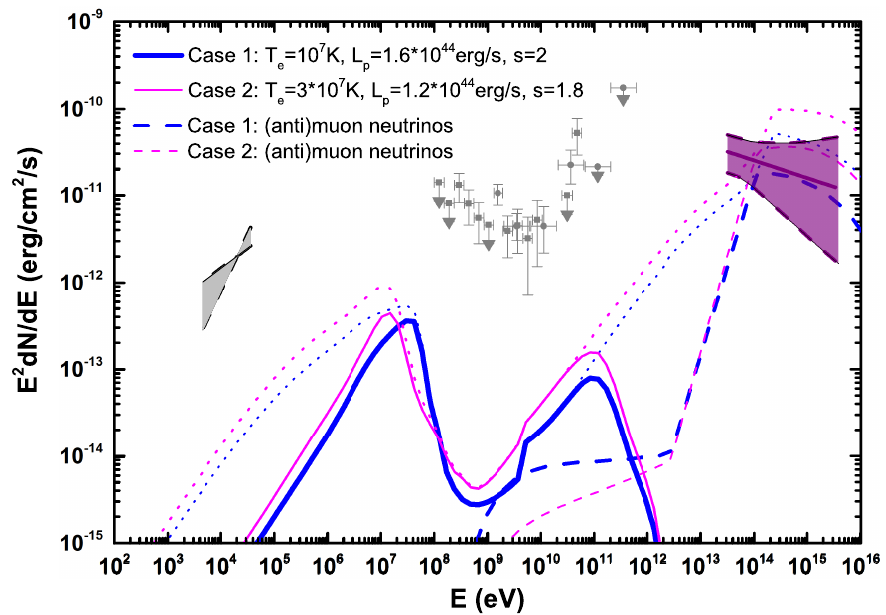
Figure 2. The predicted photon flux (solid curves) produced by secondary electromagnetic particles generated in pp collision and the corresponding neutrinos flux (dashed curves). The blue curves are for an electron temperature of T e = 10 7 K in the cloud with spectral index s = 2 of the injected CR protons, while the magenta ones are for T e = 3 × 10 7 K and s = 1.8. The purple-shaded region represents the uncertainty of observed neutrino flux and the gray region represents the X-ray flux in archival data. The gray circular data points are gamma-ray flux during the neutrino outburst analyzed by Ref. [19] and the square ones are analyzed by Ref. [18], which are almost the same as the observations in the quiescent state. The blue and magenta dotted curves represent the photon flux before the absorption by EBL and the Compton scattering by thermal electrons in the cloud. In both cases, except adopted parameter values shown in the figure, other parameters are the same, i.e., L p = 1.4 × 10 44 erg/s, E (cid:48) p ,max = 10 16 eV, B = 10 − 3 G, r c = 5 × 10 14 cm, n c = 10 11 cm − 3 , Γ j = 20 and the redshift z =